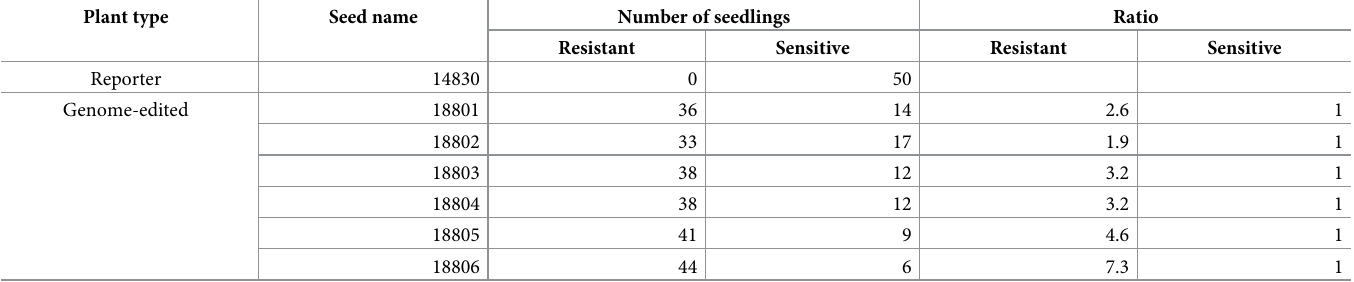
Table 1. Hygromycin resistance was examined in tobacco seedlings from seeds of untreated reporter or regenerated genome-edited plants. Number of seedlings in S1 Fig was counted. Plant